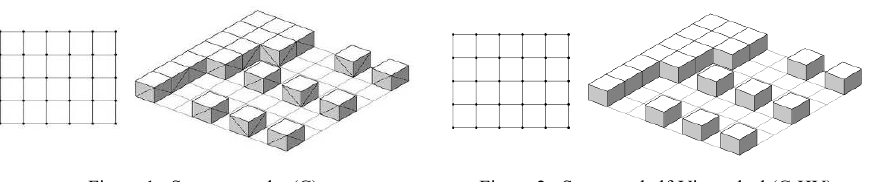
Figure 1: Structure cube (C) Figure 2: Structure half-Vierendeel (C-HV)